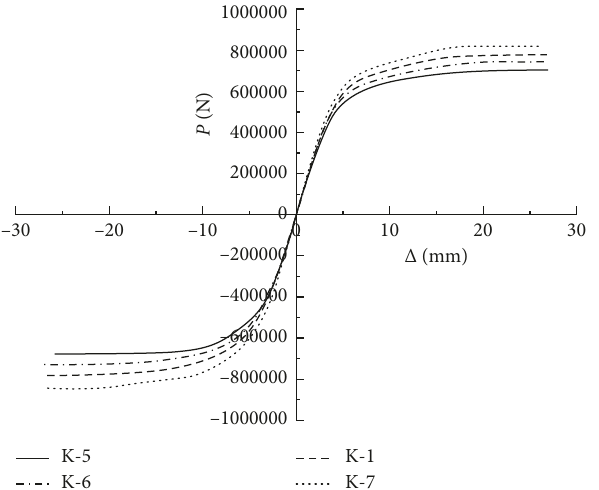
Figure 13: Curves of coefficients of energy dissipation for various reinforcement ratios.